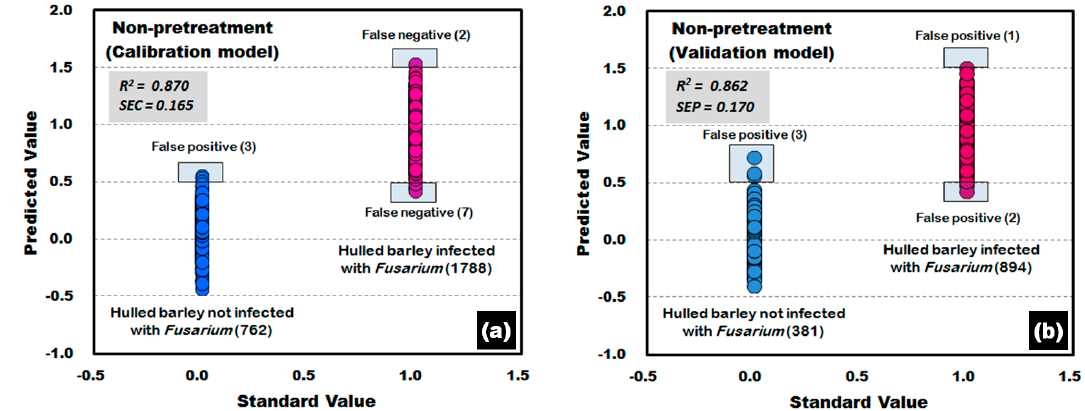
Figure 13. Fusarium discrimination calibration ( a ) and validation ( b ) results of PLS-DA model developed using the raw reflectance spectra obtained from the front side of hulled barley.